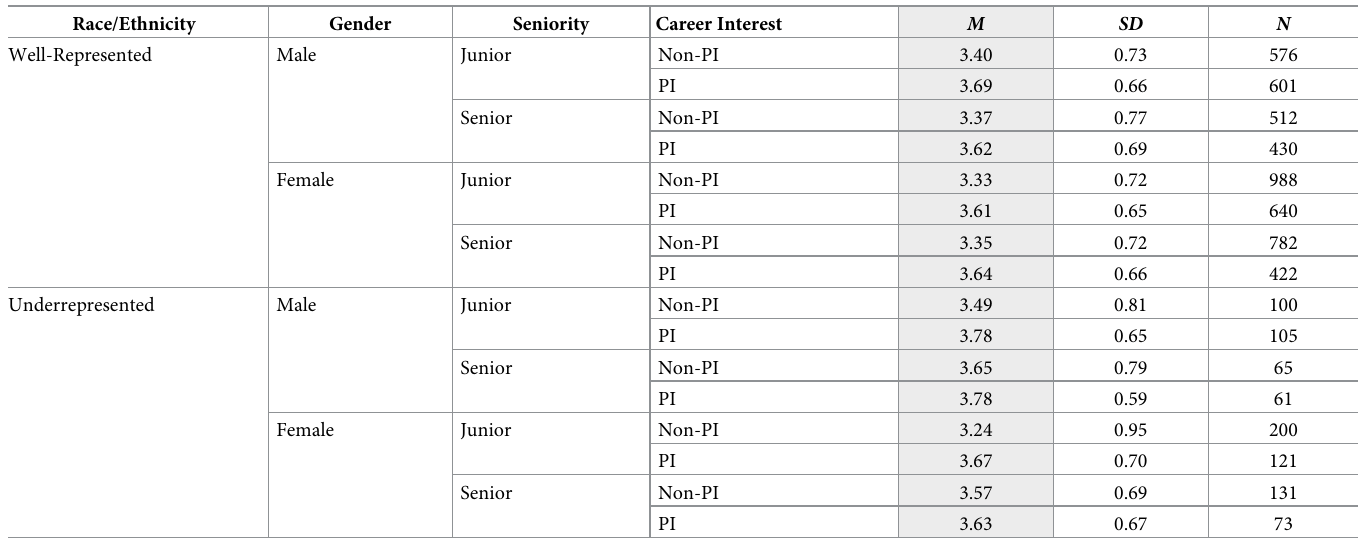
Patterns of race/ethnicity and gender were generally maintained, with newly identified interactions with seniority and career interest. Of note, UR junior trainees strongly considering a PI career were particularly high in CSE (male and female), as were UR senior male trainees interested in becoming a PI (see bold). Note : Due to some respondents skipping questions, the N above represents the population that were included in the